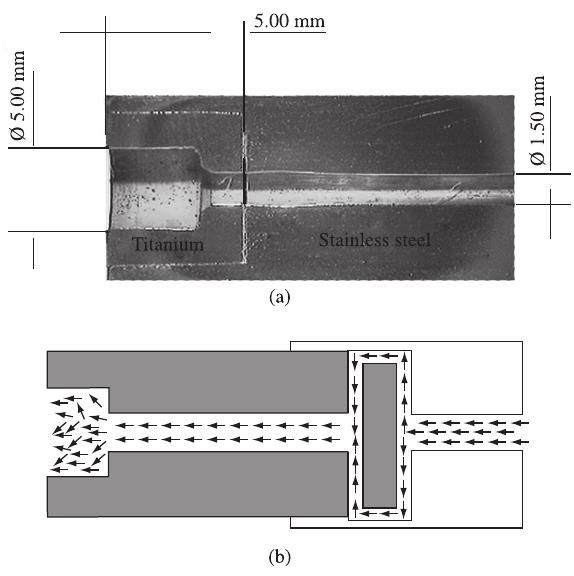
Figure 1. Titanium set in the inox cathod where happens the effect hollow cathode compounds by the small amount of Ti deposited (a) and a schematic representation of the way of the gas passing to the hollow cathode (b).